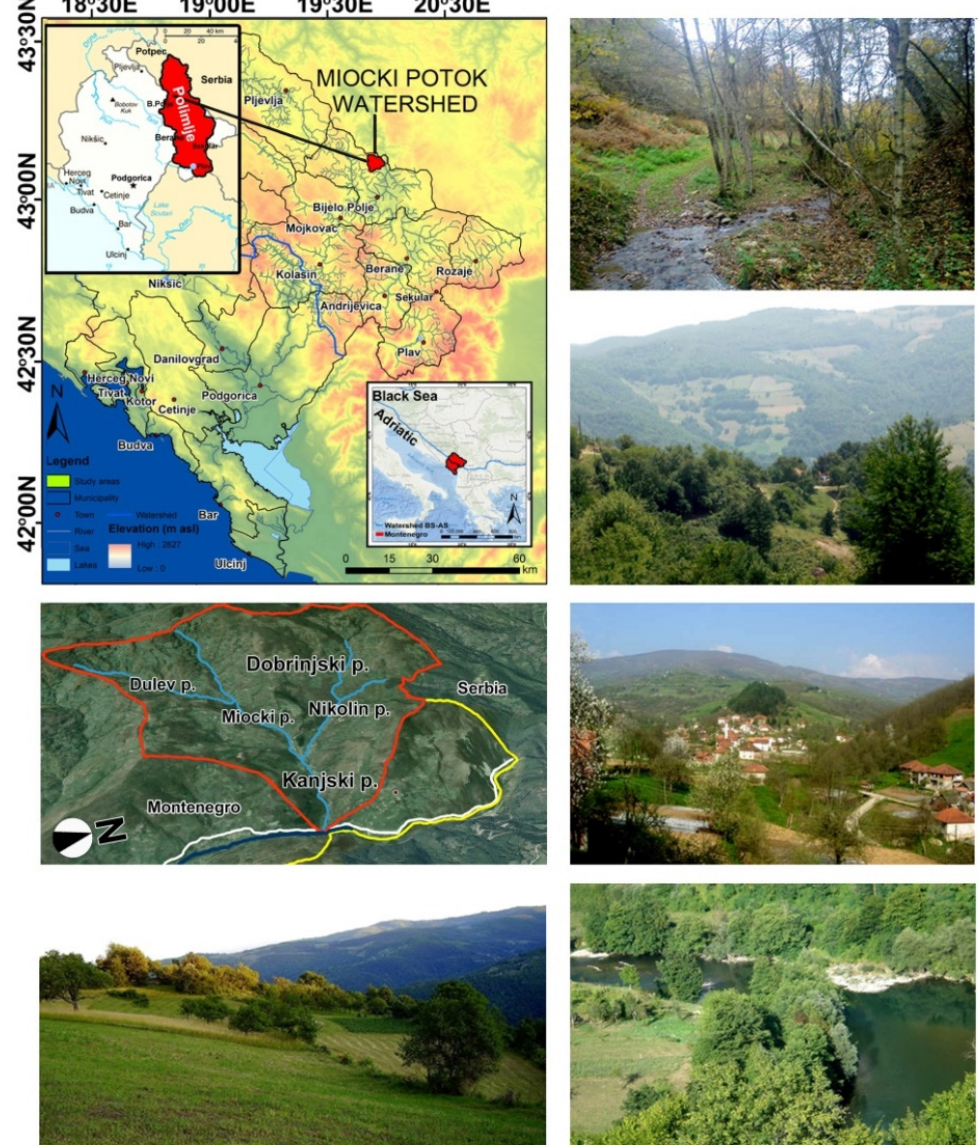
Figure 1. Study area of the Miocki Potok river basin; Examples of the landscape and of the typical land use / cover in the study catchment: From the upper reaches of the Miocki Potok to the inflow of Kanjski Potok into the Lim River, with a panoramic view on the villages Milovo and Kanje. Table 1. Precipitation and temperature for the period 1948–2020 recorded at Bijelo Polje.